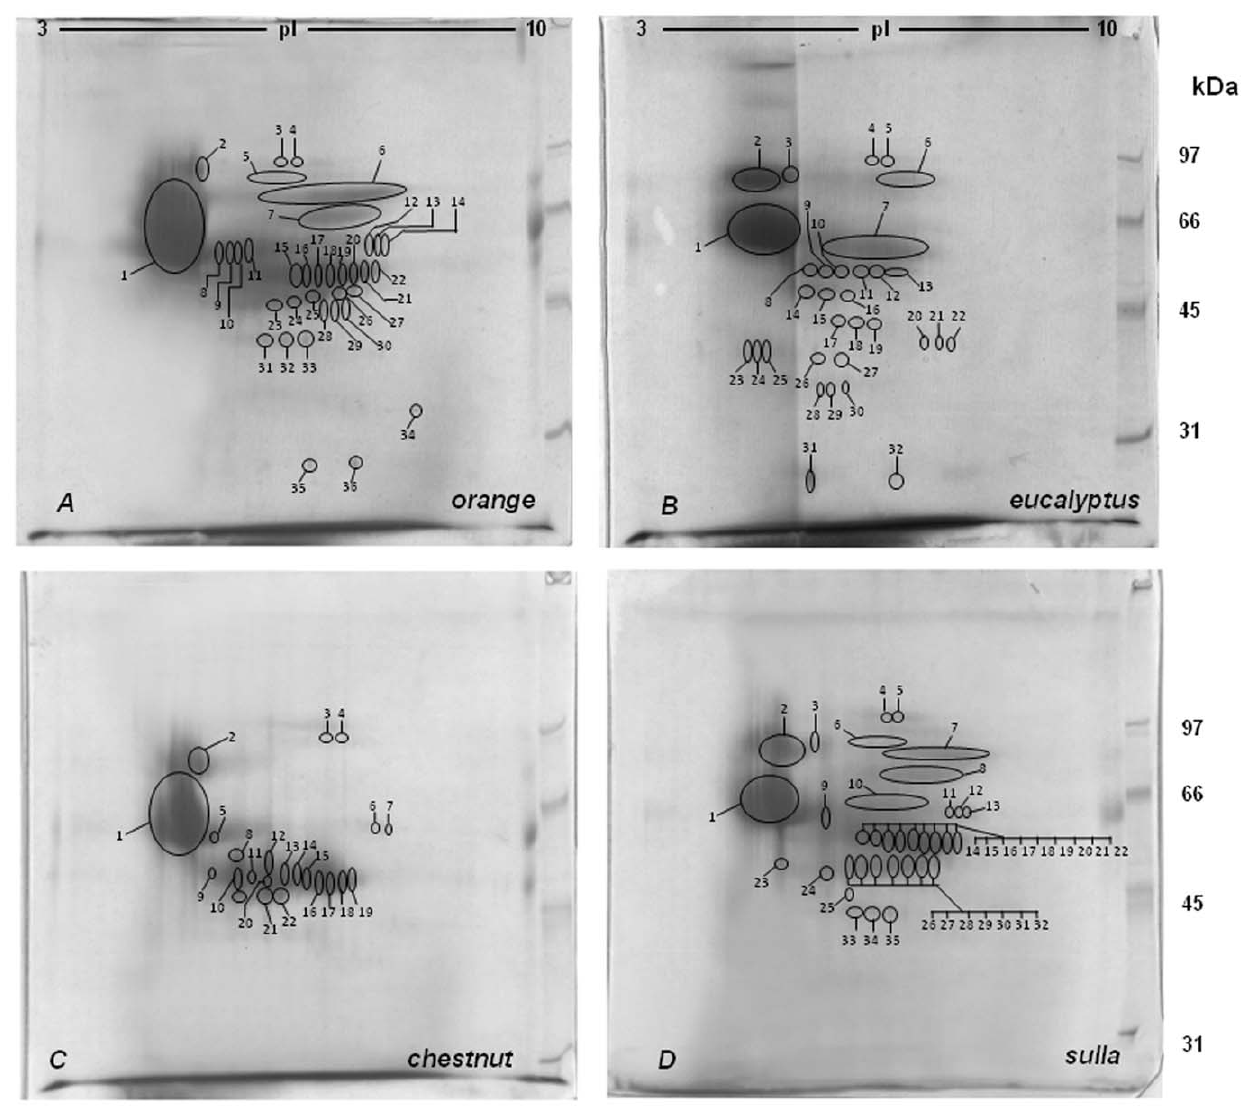
Figure 6. Bidimensional electrophoresis (2-DE) of proteins present in different unifloral honey MT1 samples. 2-DE analysis (IEF: linear pH gradient of 3–10; SDS-PAGE: 10% polyacrylamide). Coomassie stained gels: A ( orange ), B ( eucalyptus ), C ( chestnut ) and D ( sulla ). 300 m g of proteins were applied to each gel. Numbers corresponds to the protein spots identified by MALDI-ToF MS analysis.